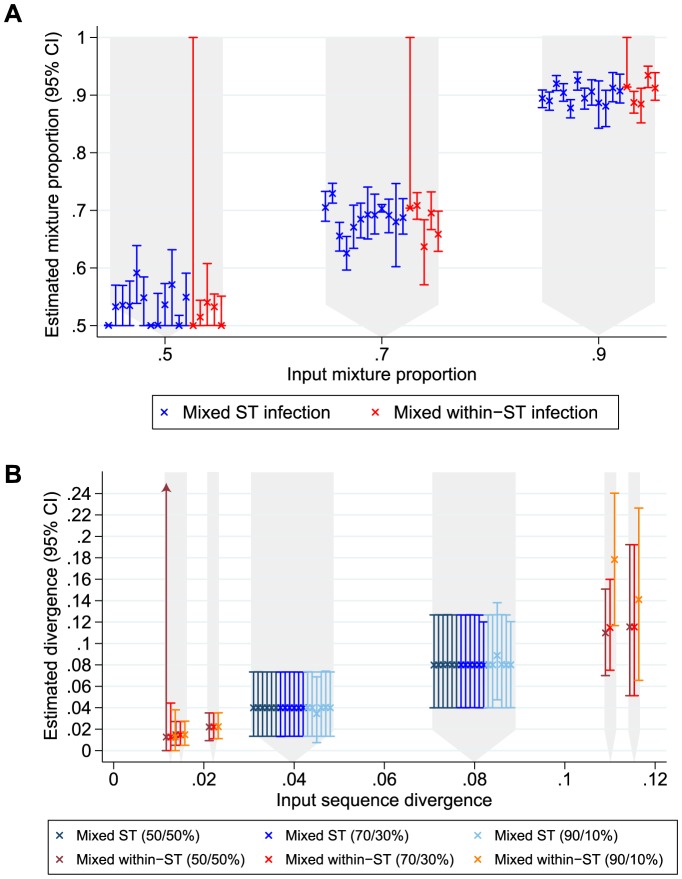

In vitro simulated mixed infections.Panel A shows the estimated mixture proportion for 3 input DNA mixture proportions. For ease of visualisation individual data points have different x-axis values, but correspond to the 3 x-axis values as indicated by the grey background. Points obtained from mixes of two differing STs are shown in red, and points from mixing two isolates of the same ST in blue. The large confidence intervals for the leftmost of each red group of samples is a sample with only a single variant site between the two input sequences, which when excluded in bootstrap sampling makes the sample appear unmixed. Panel B shows the estimated divergence between sequences for differing input divergence and mixture proportions. The leftmost group of 3 points represent a sample with a single variant site, which when excluded in bootstrap sampling makes the sample appear unmixed and estimates of d unstable between 0 and 1.